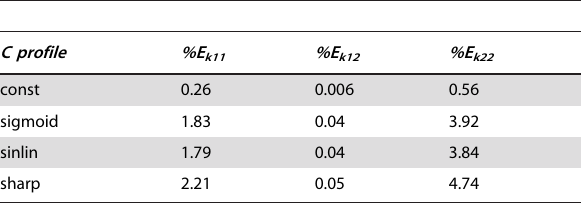
Table 5. Effect of neglecting damping on stiffness estimation with stiffness varying